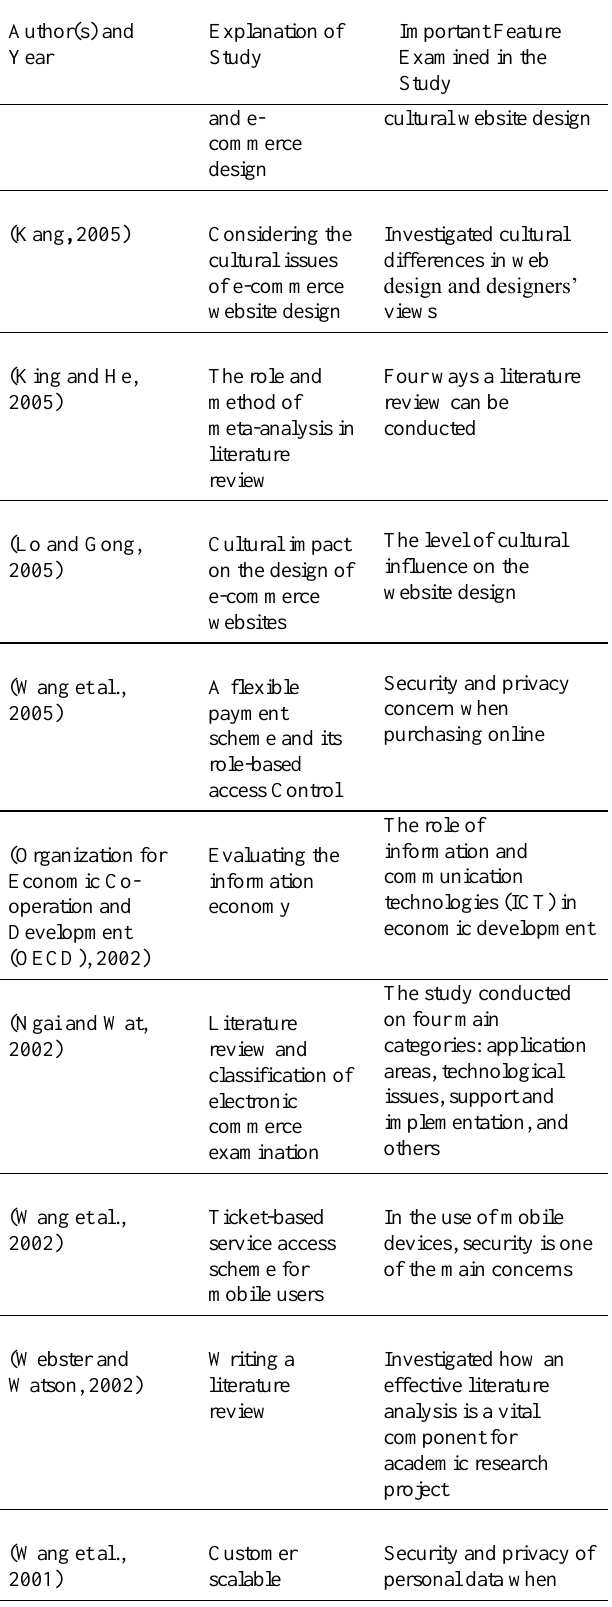
Table 3: A Summary of Selected Studies in Culture, E- commerce Website Design, and Narrative Review